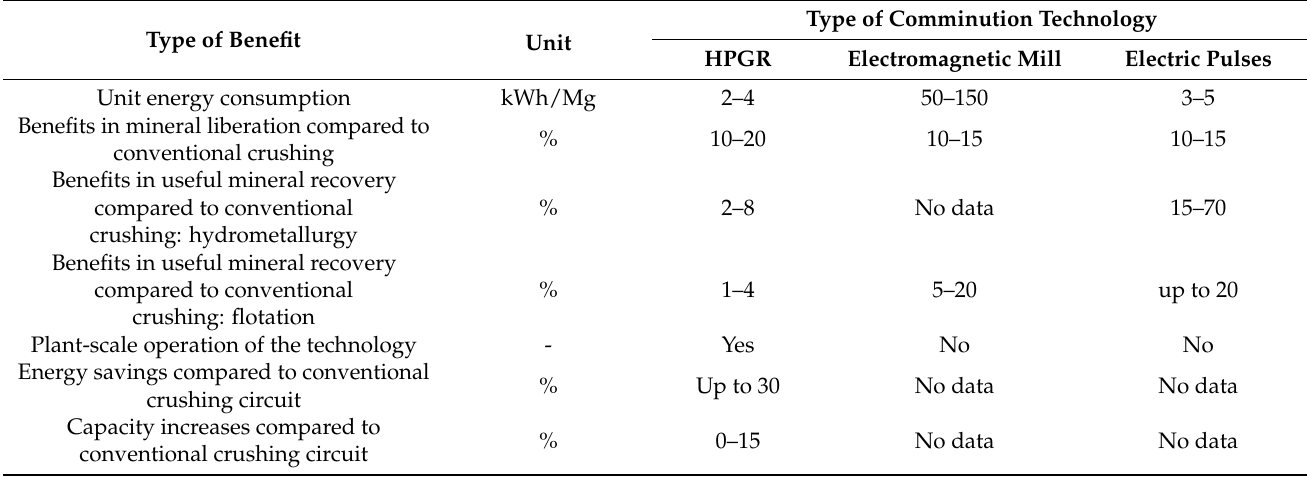
Table 1. Summary of the benefits of HPGR, electric pulse breakage, and electromagnetic mills. Type of